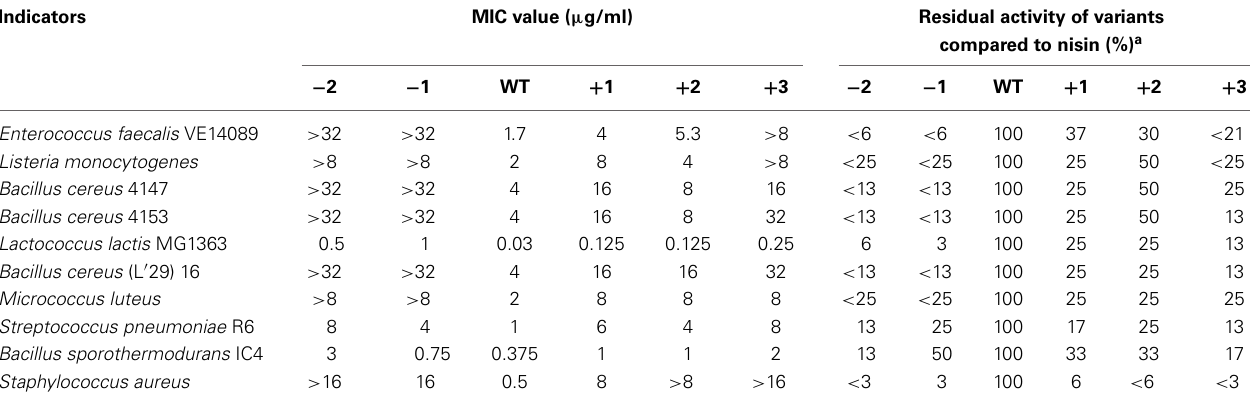
Table 4 | Minimum inhibitory concentration (MIC) of the hinge-region variants against representative Gram-positive strains, determined in liquid